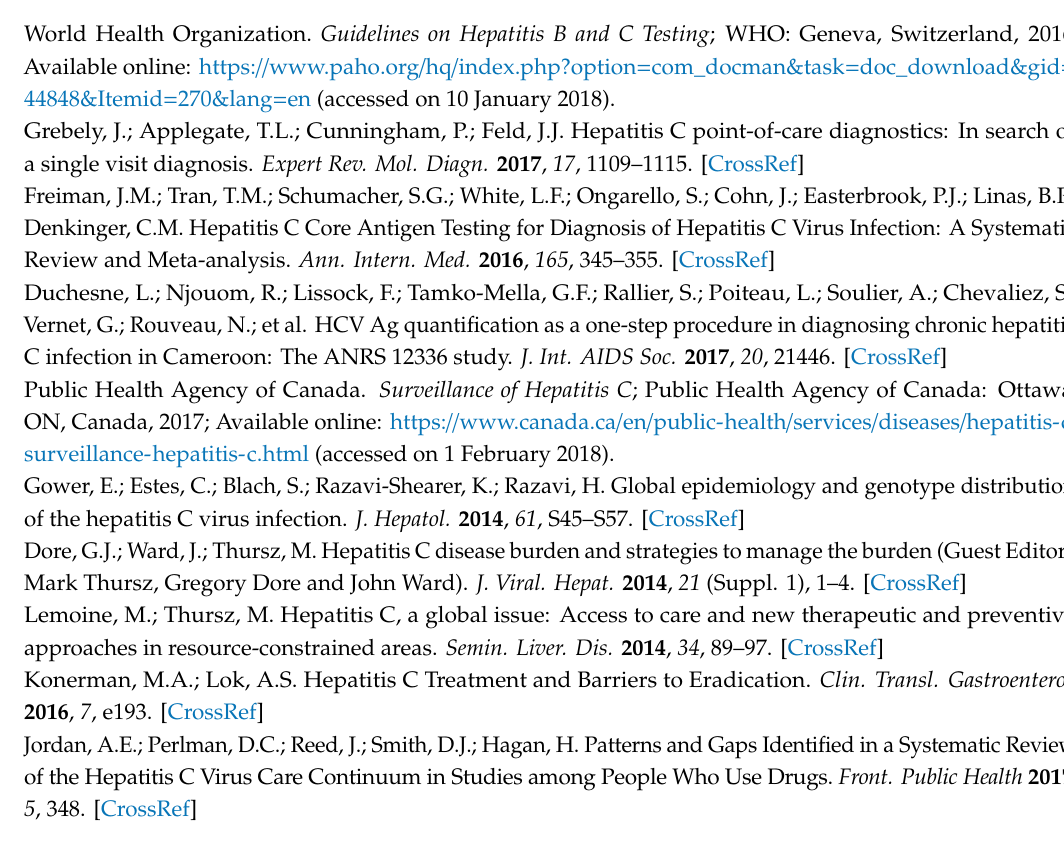
Figure S1: Correlation between serum core-Ag and HCV-RNA from serum, Table S1: Cohort characteristics, Table S2: Concordance between DBS duplicates per condition and cut-o ff , Table S3: Sensitivity and specificity of HCV core antigen from